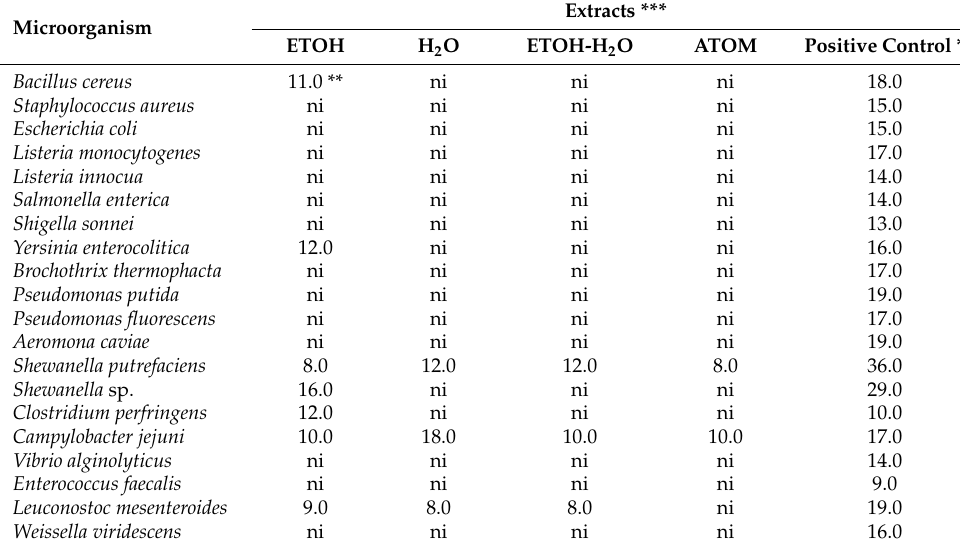
Table 2. Antimicrobial activity of extracts of S. ecuadorensis expressed as the diameter of the inhibition area